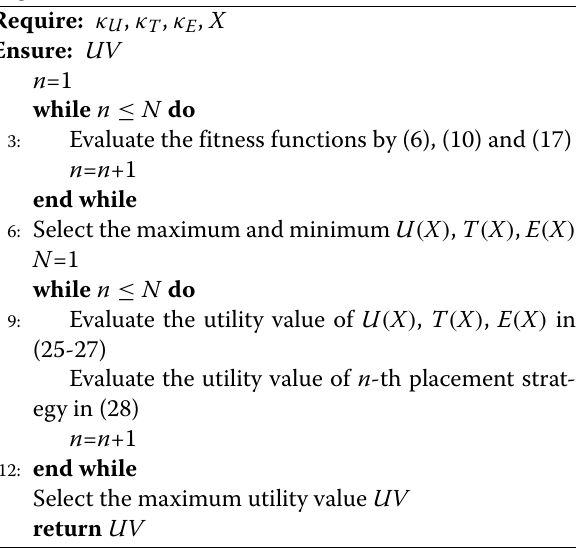
Algorithm 1 Solution evaluation